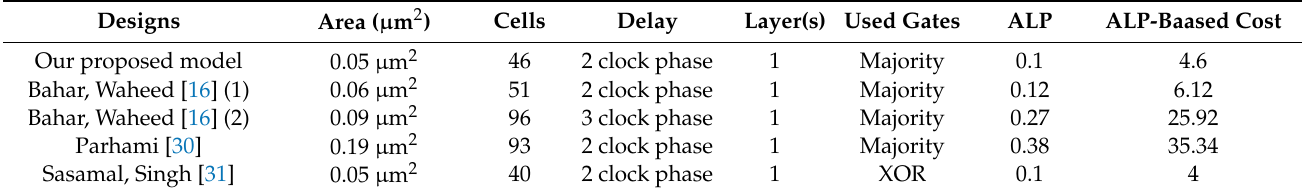
Table 3. Comparison among the proposed and previous models.